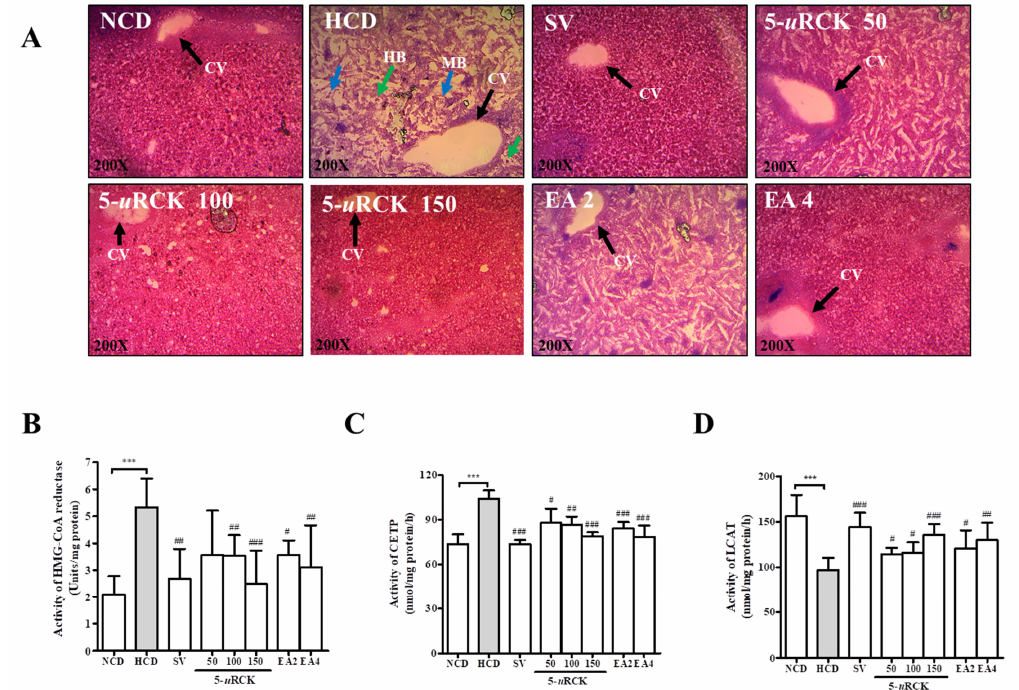
Figure 5. 5- u RCK and ellagic acid supplementation improved liver steatosis in hypercholesterolemic rats fed a high-cholesterol diet (HCD) for eight weeks. ( A ) Liver histological changes were observed after five weeks of 5- u RCK, ellagic acid, or simvastatin treatment. Liver sections stained with H&E (magnification, 200 × ). ( B ) In vivo modulatory e ff ect of 5- u RCK and ellagic acid on hepatic HMG-CoA reductase activity in HCD-fed rats. ( C ) In vivo modulatory e ff ect of 5- u RCK and ellagic acid on hepatic cholesteryl ester transfer protein (CETP) activity in high-cholesterol diet (HCD)-fed rats. ( D ) An in vivo modulatory e ff ect of 5- u RCK and ellagic acid on hepatic lecithin cholesterol acyltransferase (LCAT) activity in HCD-fed rats. The arrow indicates the central vein (CV), hepatocyte ballooning (HB), and Mallory-Denk body (MB). *** p < 0.001 versus control (NCD) group, # p < 0.05, ## p < 0.01, ### p < 0.001 versus the HCD group. All data are shown as the mean ± SD ( n =